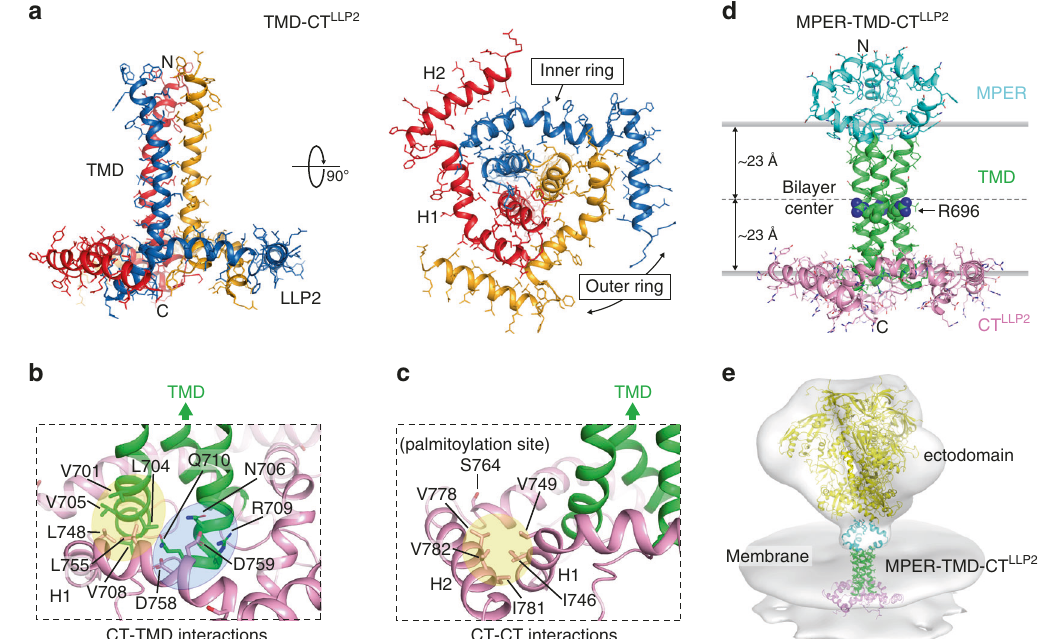
Fig. 1 Structures of TMD – CT LLP2 and MPER – TMD – CT LLP2 trimers in bicelles. a Ribbon representation of the TMD – CT LLP2 average structure from the calculated ensemble. The unstructured KS (residues 711 – 736) is omitted for clarity. The H1 and H2 helices forming the inner and outer rings of the CT baseplate, respectively, are indicated in the bottom view (right). b Close-up view of the residues establishing the CT – TMD interactions. Hydrophobic and hydrophilic interactions are shaded in yellow and light blue, respectively. The TMD and the CT are shown as green and pink ribbons, respectively. c Same as ( b ) but for the CT – CT interactions. The palmitoylation site C764 (S764 in our construct) faces the lipid bilayer interior. d Ribbon representation of the merged MPER – TMD – CT LLP2 model showing the MPER, TMD, and CT LLP2 in cyan, green, and pink, respectively. The placement of the structure in the lipid bilayer was determined experimentally using the PPT method 25 . The conserved intramembrane R696 is represented as spheres. e Fit of the MPER – TMD – CT LLP2 model and the structure of the SOSIP Env trimer (yellow; pdb ID: 5T3Z 61 ) into the low-resolution EM density (gray) of the HIV-1